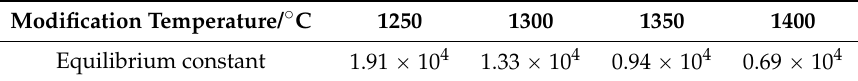
Table 5. Equilibrium constants for Equation (5) at different modification temperatures.